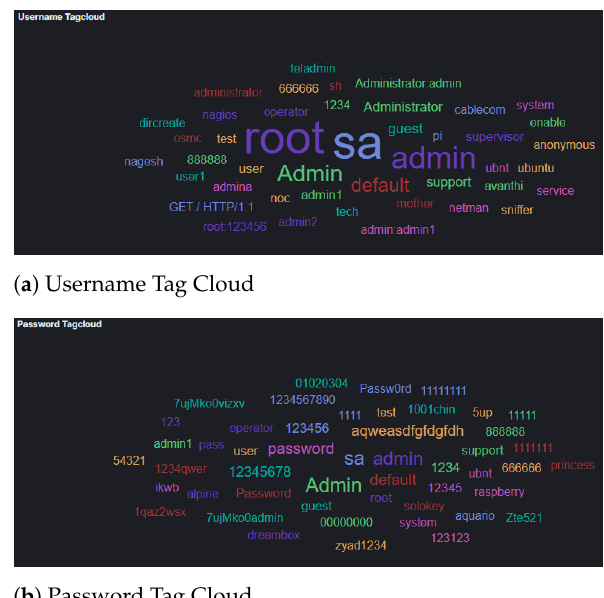
Figure 3. AWS Cowrie Username and Password Tag Cloud.